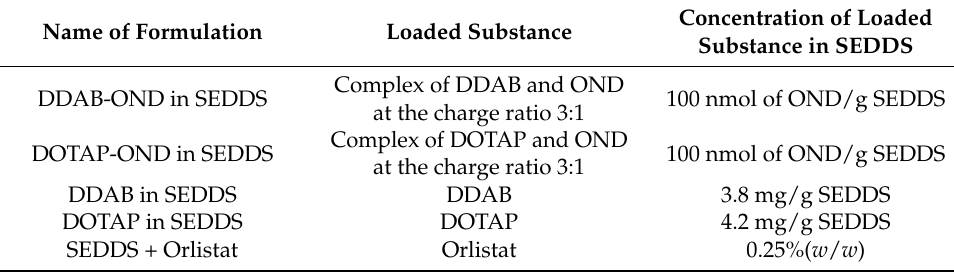
Concentration of